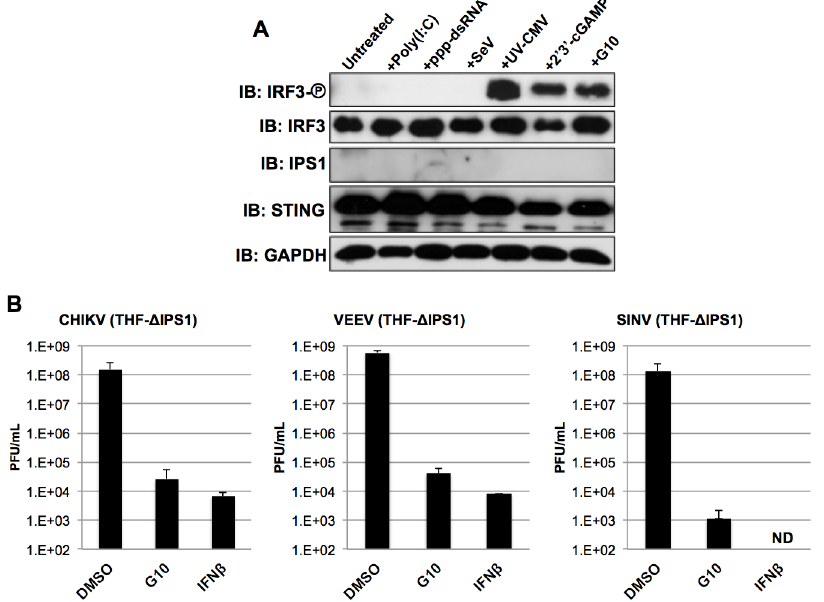
Fig 5. G10 Elicits IRF3 phosphorylation and Anti-Alphaviral Activity in Cells Lacking IPS1. (A) Immunoblot of lysates from THF-ISRE- Δ IPS1 following 6h exposure to DMSO, UV-CMV, SeV or 100uM G10 as indicated showing phosphorylation status of IRF3 S386, total IRF3, IPS1, STING, and GAPDH. (B) Average media titers +SD of CHIKV, VEEV, and SINV at 24h (VEEV) or 48h (CHIKV, SINV) post infection obtained from THF-ISRE- Δ IPS1 cells treated with 1% DMSO, 100 μ M G10, or 1000U/mL IFN β as indicated. Infections were performed in